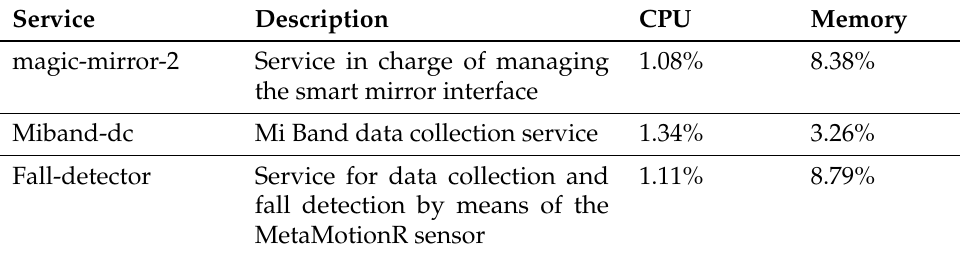
Table 8. Load of the three most highly demanding